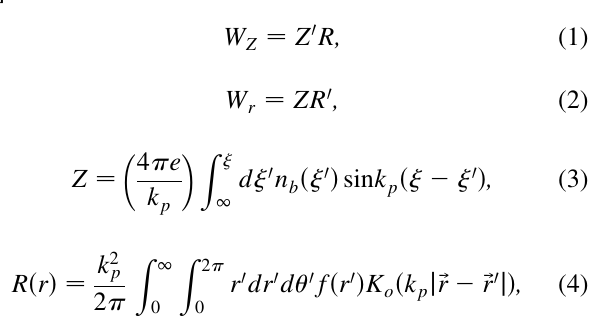
(cid:2) (cid:4); r (cid:3) b